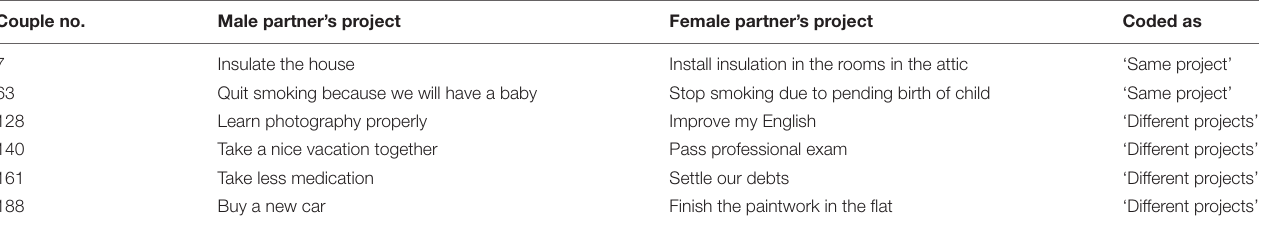
TABLE 3 | Examples of couples’ personal projects. Couple